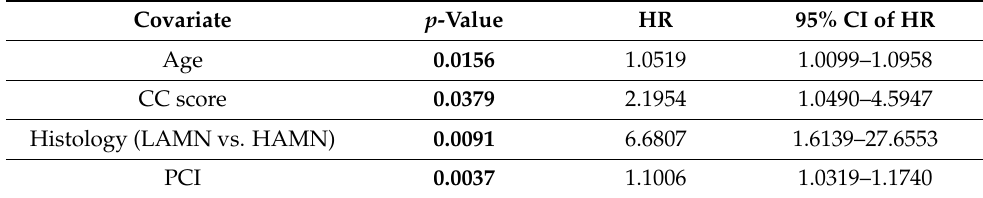
Table 4. Multivariate Cox regression for OS. HR: hazard rate, CI: confidence